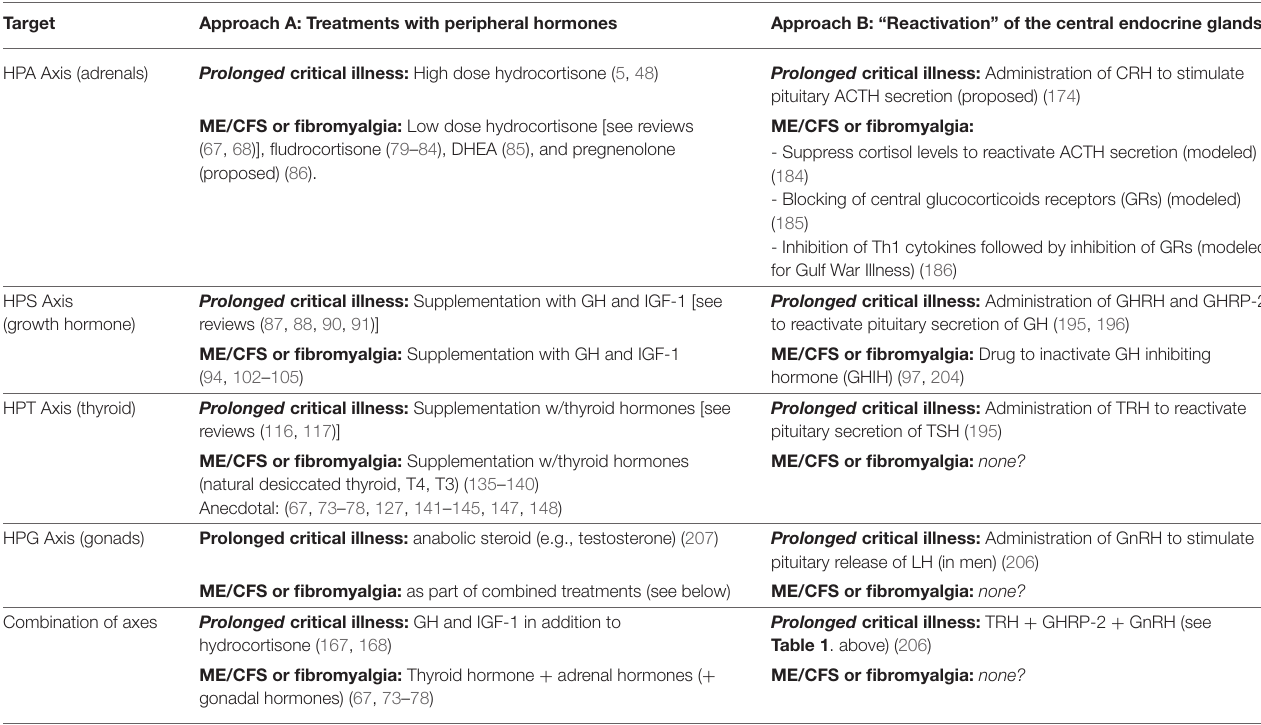
TABLE 2 | Summary of treatments proposed and trialed to correct for suppressed endocrine axes in critical illness, and ME/CFS and fibromyalgia.